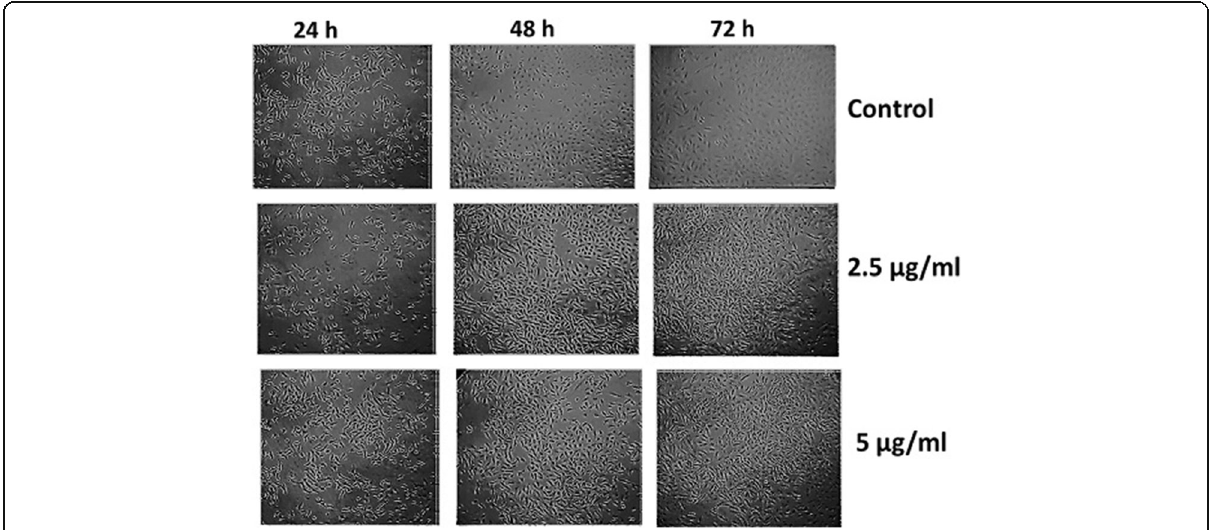
Fig. 10 Effect of SCF on morphology of A-549 cells in vitro. A-549 cells were cultured in vitro and treated with different dosages of SCF and cell morphology was observed. Untreated cells served as control. No significant change in the morphology of A-549 cells was observed post treatment with